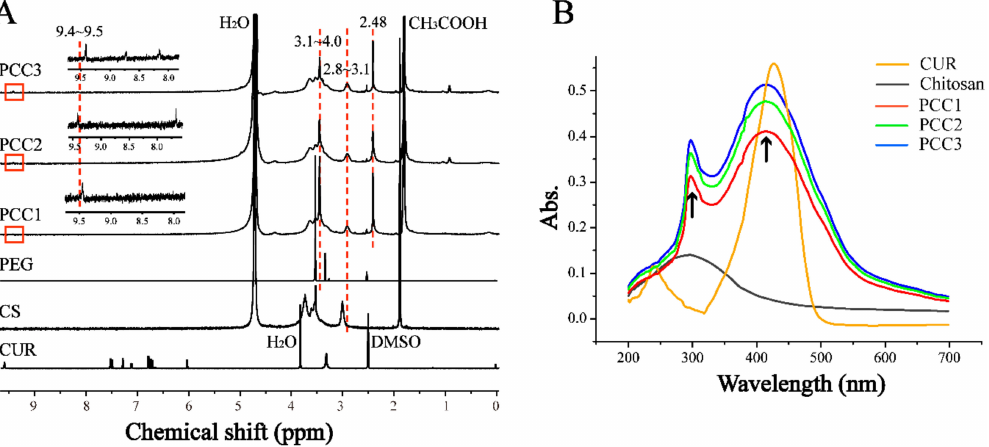
Figure 3. ( A ) Nuclear Magnetic Resonance ( 1 H NMR) spectra for CUR, CS, PEG, PCC1, PCC2 and PCC3; and ( B ) Ultraviolet (UV-Vis) spectra of CUR, CS, PCC1, PCC2 and